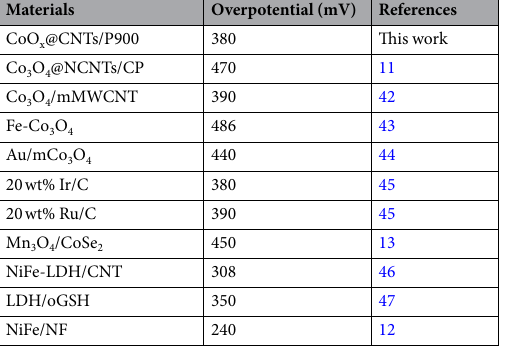
Table 2. OER activities of some electrocatalysts in 0.1 M KOH at a current density of 10 mA.cm − 2